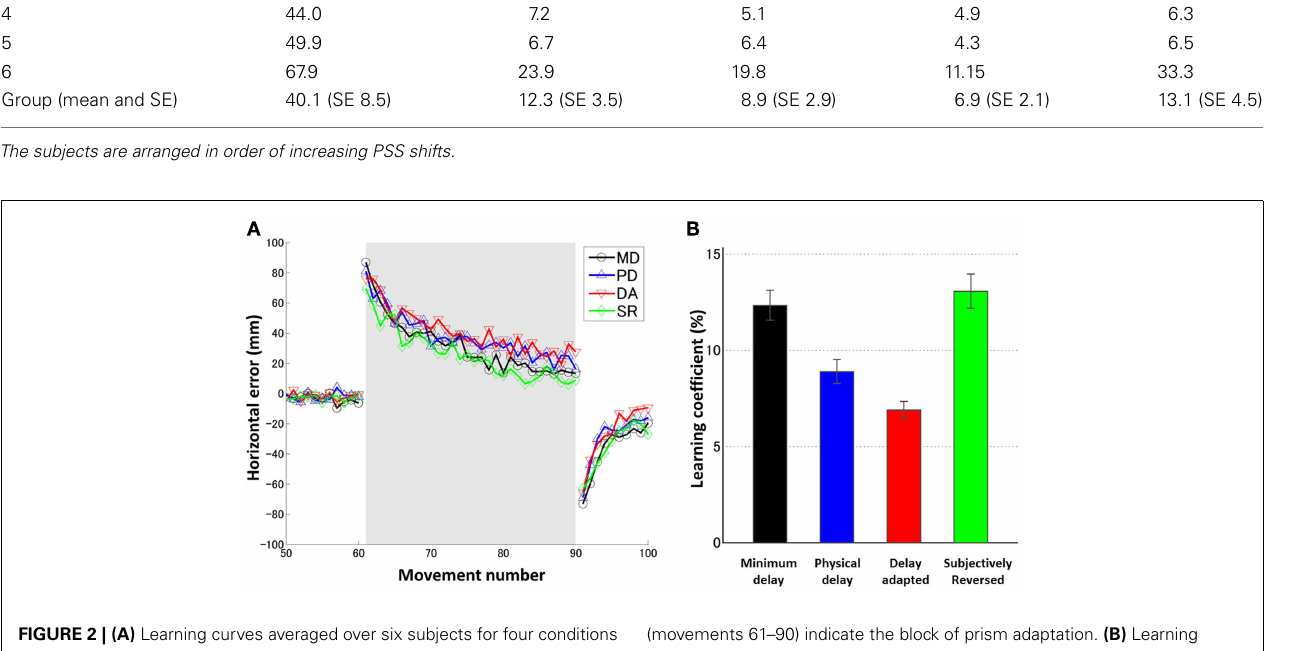
FIGURE 2 | (A) Learning curves averaged over six subjects for four conditions (MD: black circle, PD: blue upward-pointing triangle, DA: red downward-pointing triangle, and SR: green diamond).The gray shaded trials